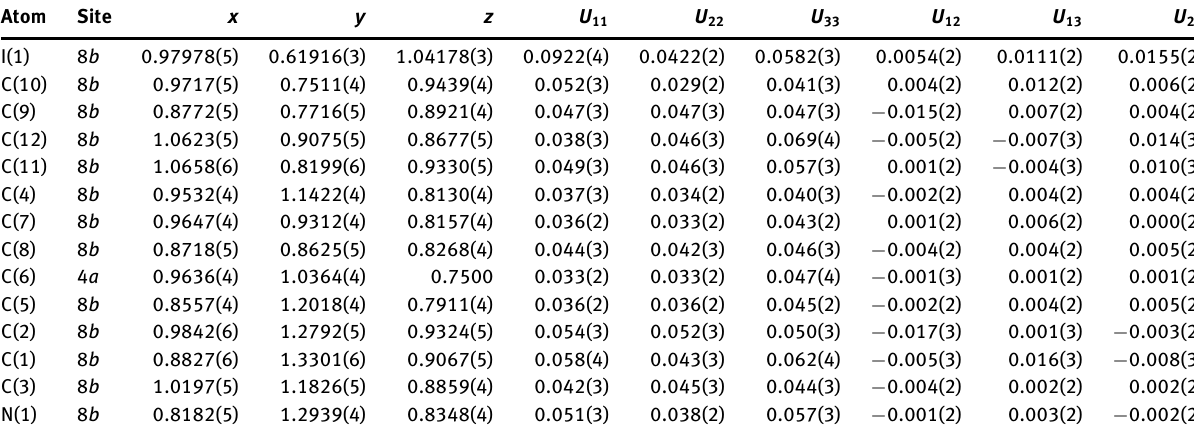
Table 3: Fractional atomic coordinates and atomic displacement parameters (Å 2